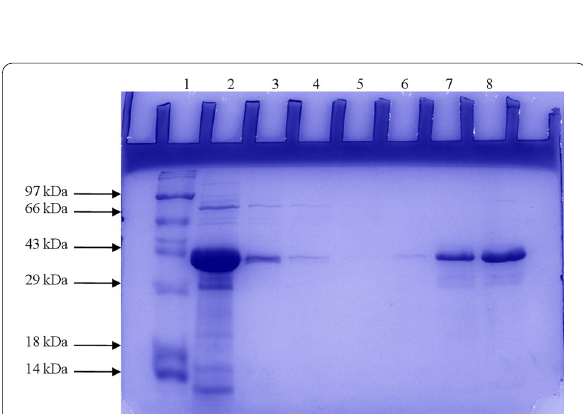
Fig. 3 Purification of recombinant protein and its analysis on 12% SDS PAGE. Lane 1—Protein marker, Lane 2—Induced sample, Lane 3—Flow through, Lane 4—Unbound fraction 1, Lane 5—Unbound fraction 2, Lane 6—Elaunt 1, Lane 7—Eluant 2, Lane 8—Eluant 3